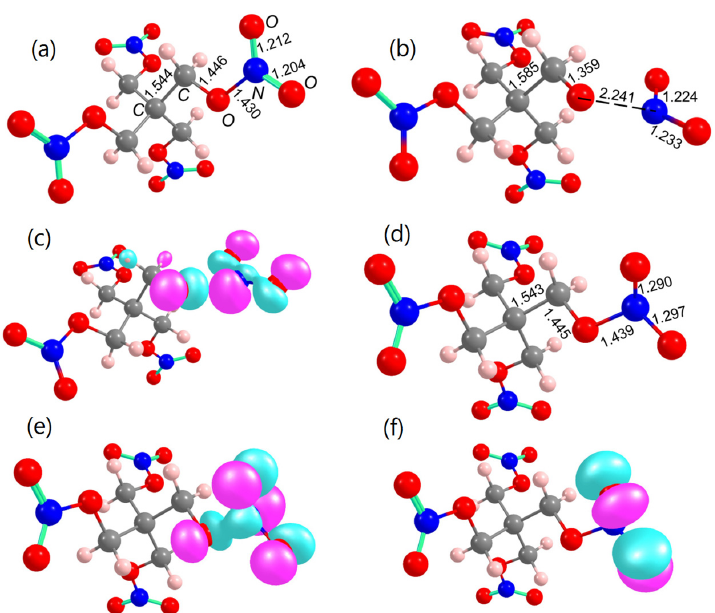
Figure 4. The geometric configurations of equilibrium molecular structures of ( a ) the ground state neutral PETN molecule; ( b ) PETN radical anion; ( c ) electron component of PETN radical anion; ( d ) PETN in the triplet state; ( e ) electron and ( f ) hole components of PETN in triplet state. The formation of the vertical singlet-triplet transition in PETN was simulated by using TD B3LYP and Δ SCF approximations. The energy required to form a triplet state is 3.88–4.22 eV,